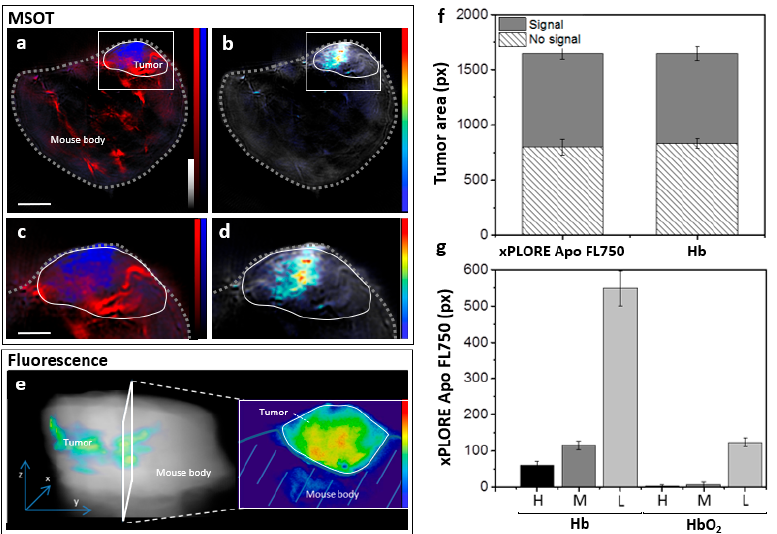
Figure 3. Intratumoral distribution of xPLORE-Apo-FL750©. Mammary gland 4T1 tumors were allografted into mice treated with doxorubicin for 24 h, then injected intravenously with xPLORE- Apo-FL750© and imaged first by MSOT in vivo and secondly by fluorescence imaging ex vivo. ( a ) Optoacoustic images showing overlaid deoxyhemoglobin (blue scale), oxyhemoglobin (red scale) distribution and anatomical background (800 nm: isosbestic point, greyscale). ( b ) Optoacoustic image showing the distribution of the xPLORE-Apo-FL750© probe (heat scale) merged with anatomical background (greyscale) in the same transverse plane as in ( a ). ( c , d ) Insets showing magnified views of the region enclosed in the white dotted lines in ( a ) and ( b ) respectively, indicating tumor margins. ( e ) Three-dimensional reconstruction of sequential planar ex vivo fluorescence images of tumor cryoslices (left) and exemplary two-dimensional transverse fluorescence image of a single tumor cryoslice (right). ( f ) Tumor area fractions containing xPLORE-Apo-FL750© or deoxyhemoglobin signal. ( g ) Spatial co-localization of xPLORE-Apo-FL750© and deoxyhemoglobin within the tu- mor tissue area after classifying pixels with positive xPLORE-Apo-FL750© signal into three signal intensity-based classes: high (H), medium (M) or low (L)